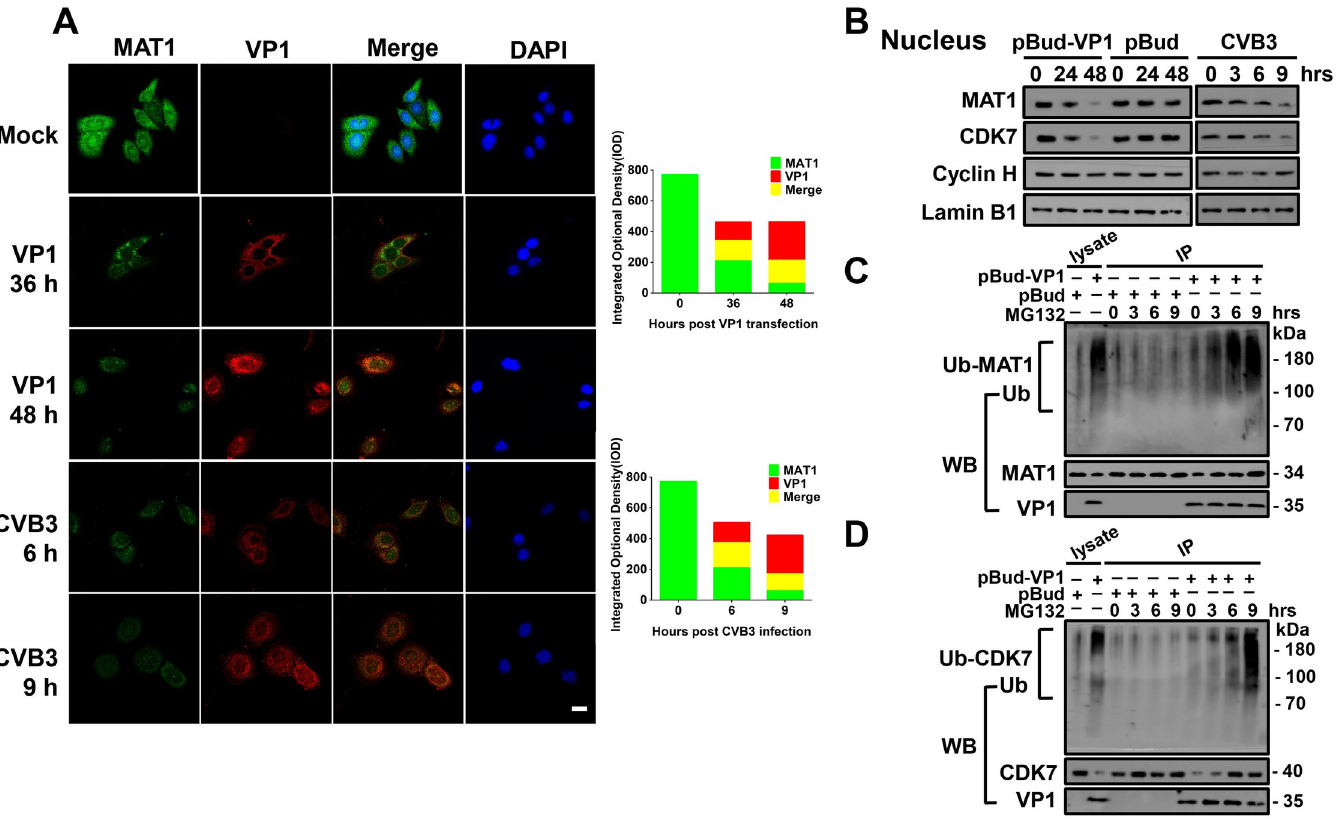
Fig 3. CVB3 VP1 impairs the assembly of a functional CAK complex. (A) Confocal microscopy analysis of the abundance of VP1 and MAT1 in HPAC cells, Cells were detected with monoclonal antibodies to MAT1 (Alexa-488; green) and polyclonal anti-VP1 (Alexa-647; red), and counterstained with DAPI to show the nucleus. The MAT1 and VP1 images were merged. Scale bar: 10 μ m. The integrated optical density (IOD) represented the fluorescent signal was obtained by statistical analysis of 20 fields (5–8 cells in each field) randomly selected using Image J software. (B) Immunoblot analysis of the nuclear-localized accumulation of MAT1, CDK7, Cyclin H in CVB3 infected, VP1 and pBud transfected HPAC cells by specific antibodies. Original blots are shown in S17 Fig for statistical analysis. (C) CVB3 VP1 induces ubiquitination-proteolysis of MAT1. The cell lysates of pBud-VP1 and pBud transfected cells were incubated with monoclonal antibody against MAT1 with 0, 3, 6, 9 hrs. The generated blot was then analyzed by immunoblotting with anti-ubiquitin antibody. Original blots are shown in S18 Fig for statistical analysis. (D) CVB3 VP1 induces ubiquitination-proteolysis of CDK7. Original blots are shown in S19 Fig for statistical analysis. Values are shown as the mean ± SEM of three independent experiments. ( � P < 0.05, �� P <